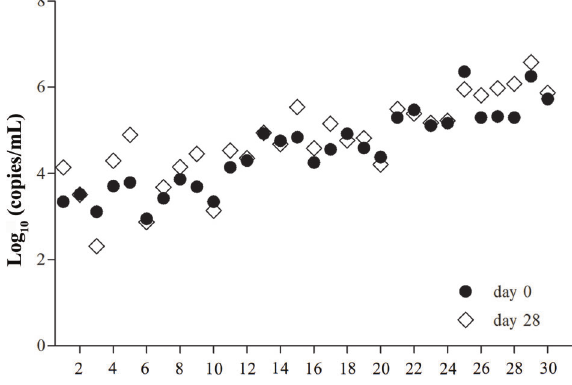
Figure 2. Comparison of Ureaplasma urealyticum DNA concen- trations using extracted DNA at day 0 and at day 28 of storage at 4°C.